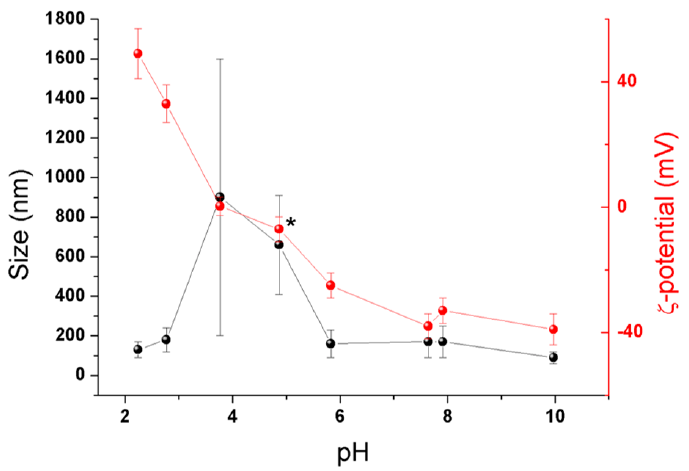
Figure 2. Particle size (black) and ζ -potential (red) of MIL-125-NH 2 NPs in water as a function of pH; the autogenous pH (ca. 4.9) is identified in the plot with an asterisk (*).